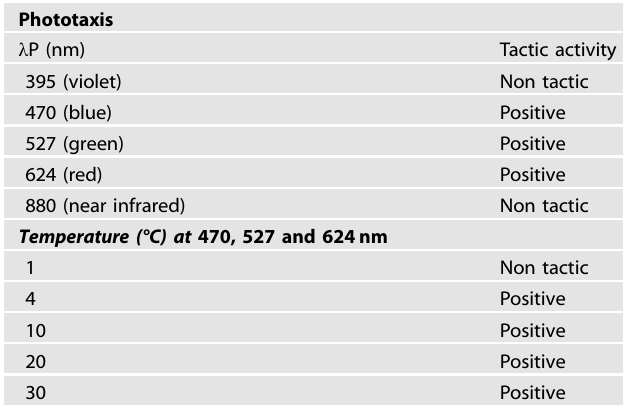
Table 3. Phototactic behavior of strain